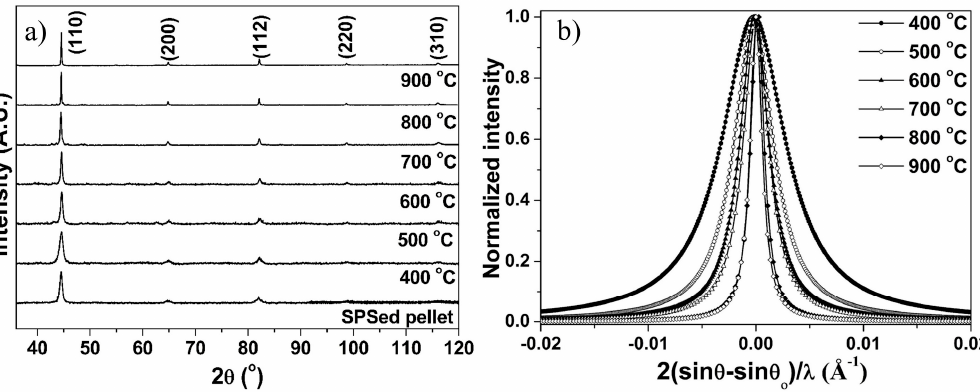
Figure 5. Effect of annealing temperature on ( a ) XRD line profiles of the annealed Fe–10Cr–3Al powder and the SPSed Fe–10Cr–3Al pellet; ( b ) broadening of (110) peak of the annealed Fe–10Cr–3Al powder. Here, θ and θ o are diffraction and exact Bragg angles, respectively.